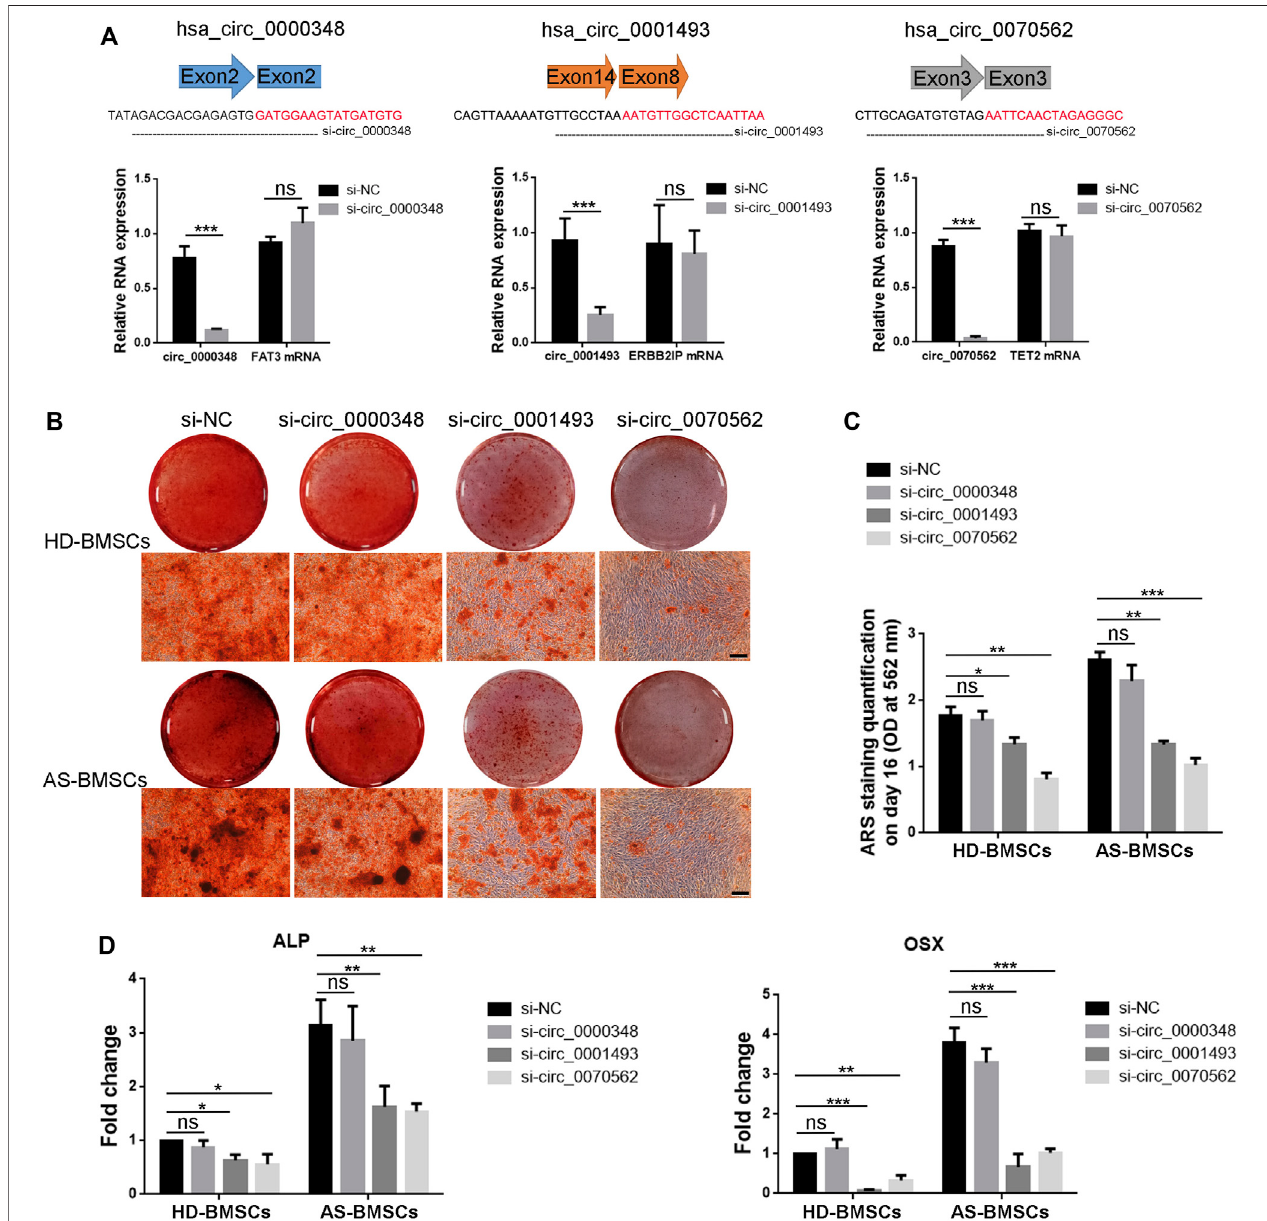
FIGURE 8 | Function of hsa_circ_0000348, hsa_circ_0001493 and hsa_circ_0070562 in osteogenic differentiation of AS-BMSCs and HD-BMSCs. (A) . Small interfering RNAs (siRNAs) targeted the junction sites of circ_0000348, circ_0001493 and circ_0070562 were used. qPCR results indicated that the expression of circ_0000348, circ_0001493 and circ_0070562 were decreased, while the expression of FAT3, ERBB2IP and TET2 were not changed in BMSCs transfected with si- circ_0000348,si-circ_0001493,si-circ_0070562ornegativecontrolsiRNA(si-NC),respectively,for48 hata fi nalconcentrationof80 nM.N=3BMSCssamples. (B) . ARS results of HD-BMSCs and AS-BMSCs transfected si-circ_0000348, si-circ_0001493, si-circ_0070562 or si-NC, respectively, after ostegenic induction for 14 days.Scalebar=100 μ m. (C) .ThequantitativeARSstainingresults(Absorbanceat562 nm)in (B) .N=6BMSCs. (D) .qPCRfoldchangeresultsofALPandOSXmRNA levels of HD-BMSCs and AS-BMSCs transfected si-circ_0000348, si-circ_0001493, si-circ_0070562 or si-NC, respectively, after ostegenic induction for 3 days. N = 6 BMSCs. * p < 0.05, ** p < 0.01, *** p < 0.001.